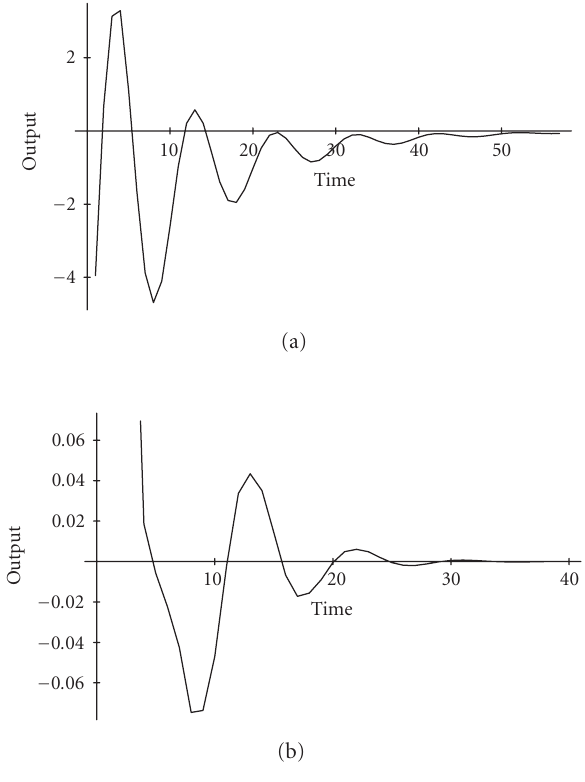
Figure 4.1. (a) Output for the first estimator only and (b) output for the combined estimator.